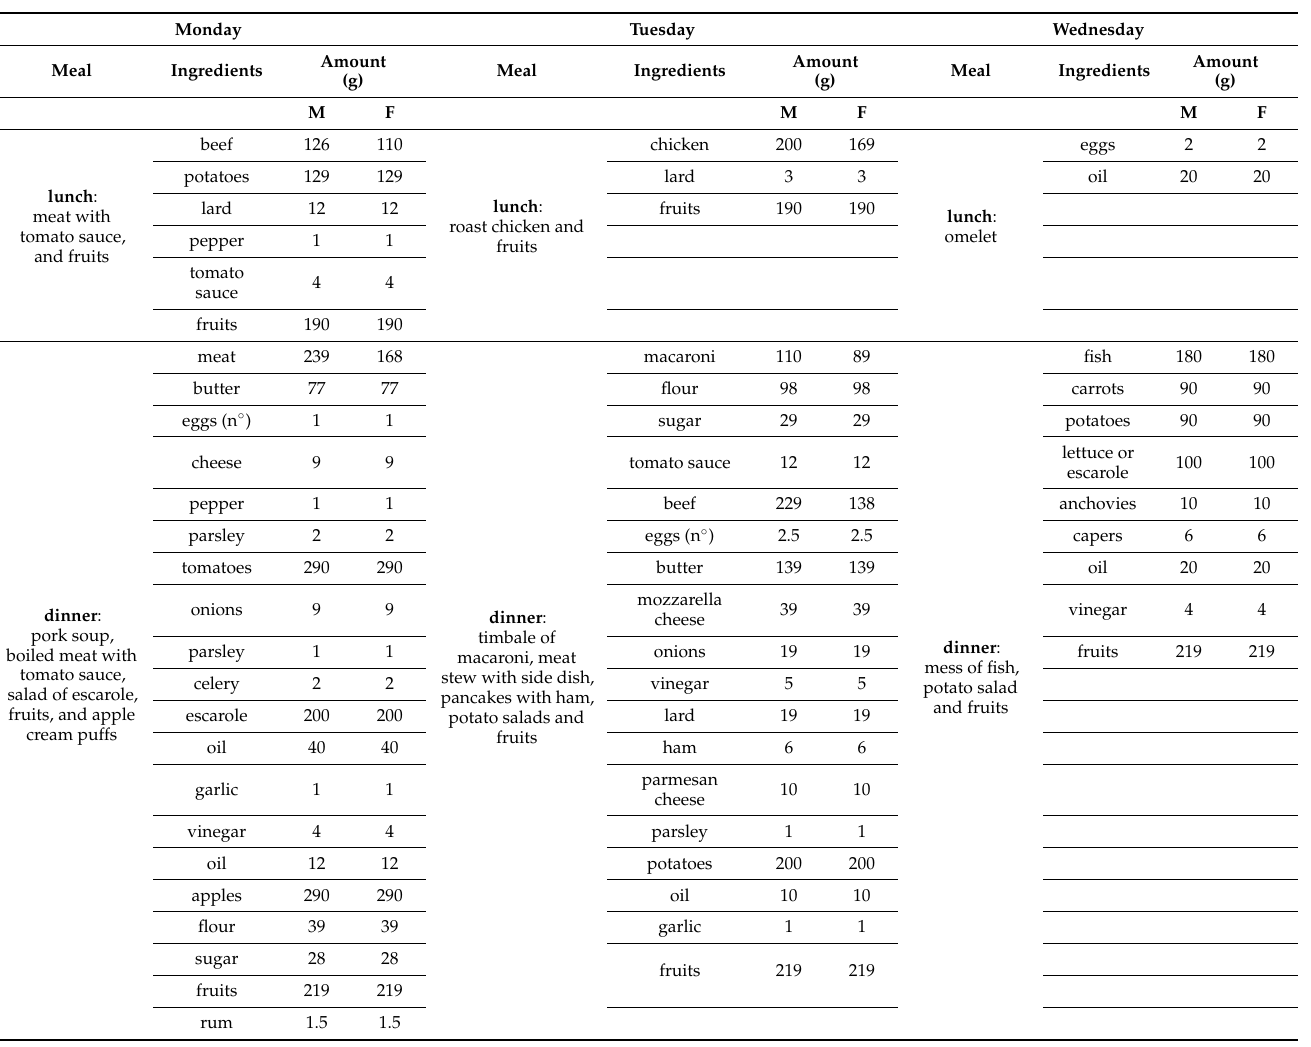
Table 9. Individual meals for 1st and 2nd class patients at lunch and dinner. Months: September and October (1) 1887.